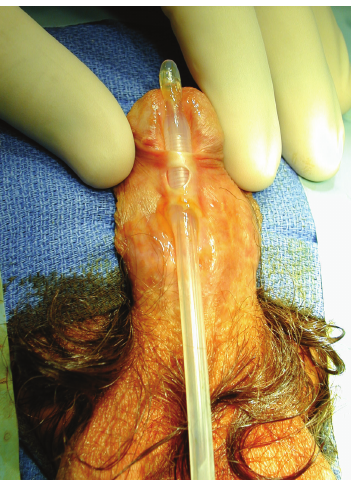
Figure 1: Typical complex urethral stricture after childhood hypospadias repair, with a distal penile location and complicating fistulae.